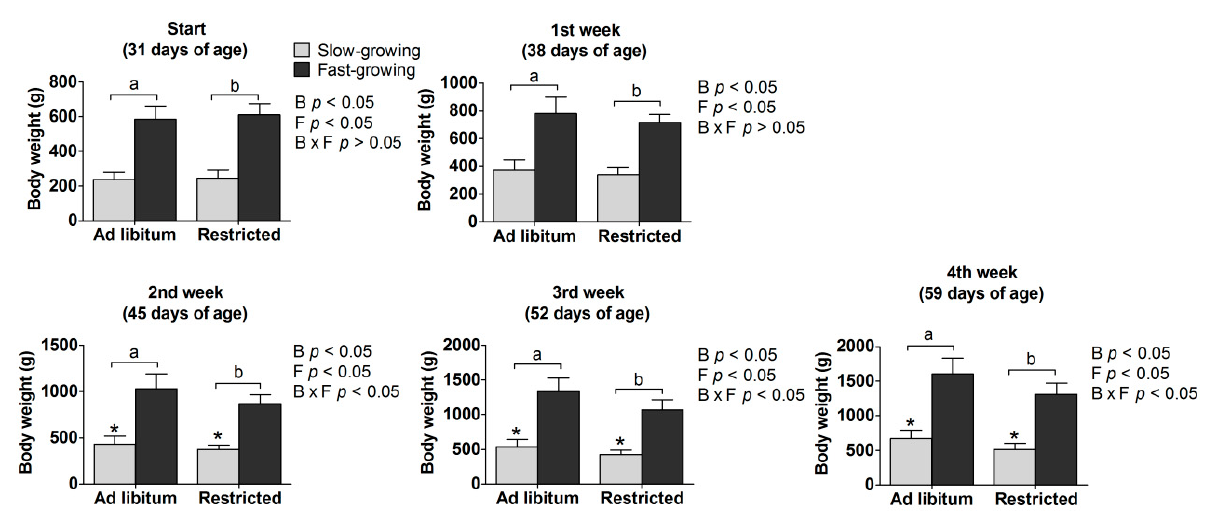
Figure 1. Body weight (g) of birds in the four treatments at different ages. a, b represent the significant difference between the ad libitum and feed restricted treatments ( p < 0.05). * means significant difference in the ad libitum or feed restricted treatments between slow- and fast-growing chickens ( p < 0.05). B: breed, F: feeding method, B × F: interaction between breed and feeding method.